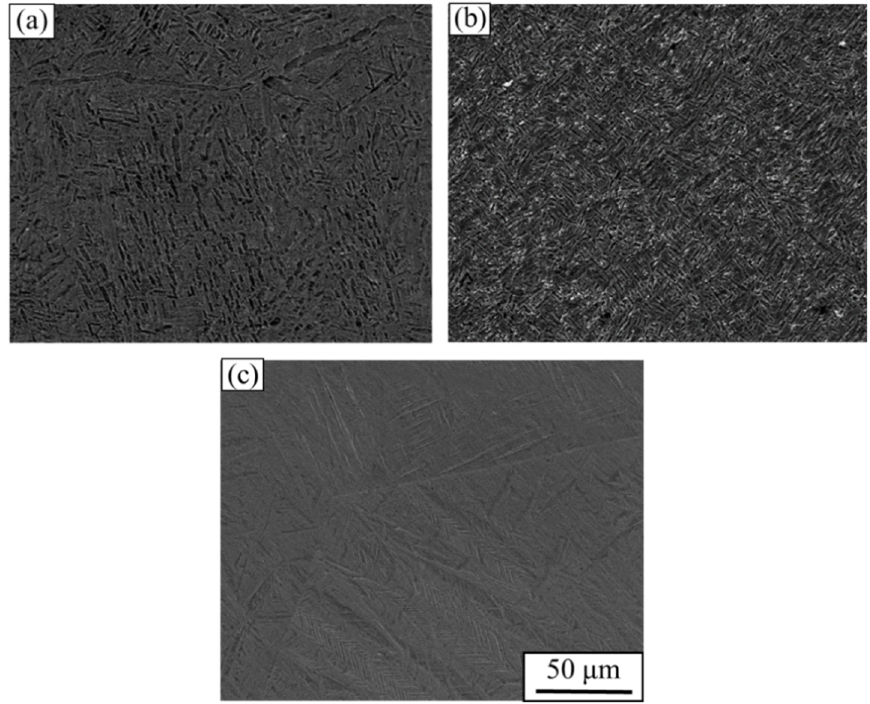
Figure 8. Microstructure of Ti-1023 stress at abnormal temperature: ( a ) original structure; ( b ) structure after 500 °c heating; ( c ) structure after torsional impact at 500 °C.